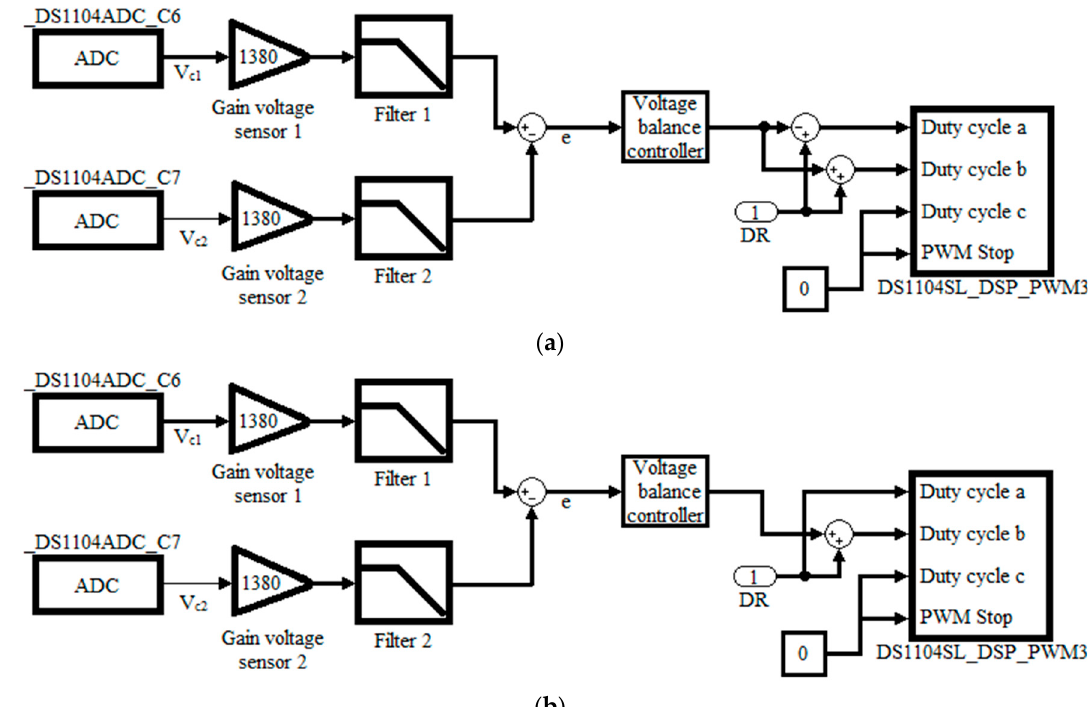
Figure 10. Matlab/Simulink implemented model on the dSPACE DS1104 board: ( a ) VB control applied on the TLBDC lower switch, and ( b ) VB control applied on either switche of the TLBDC.